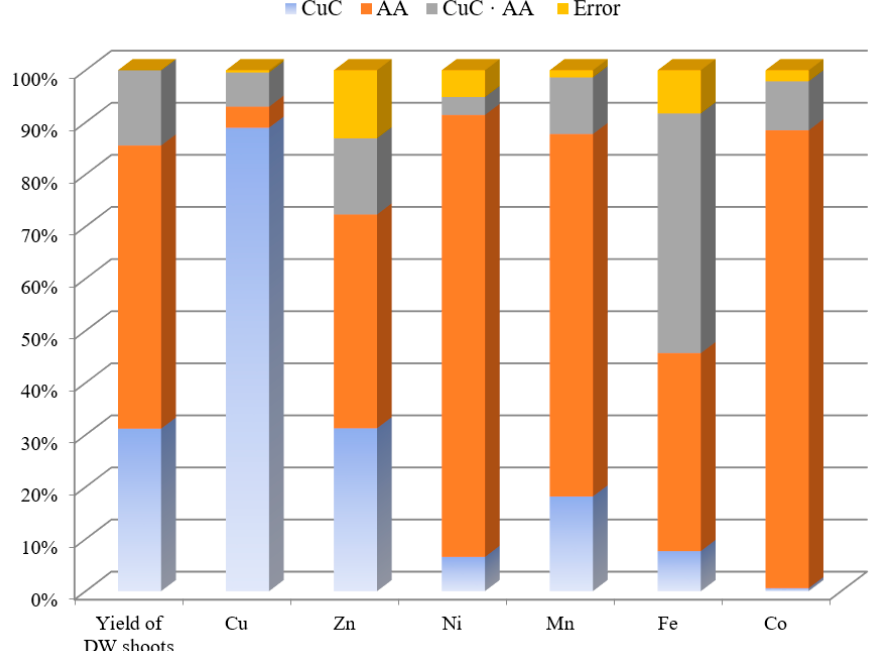
Figure 1. Per cent contribution of variable factors according to the concentration of trace elements in shoots of maize ( Zea mays L.): CuC—Cu contamination; AA—amendments application; CuC · AA—interaction between Cu contamination and amendments application.